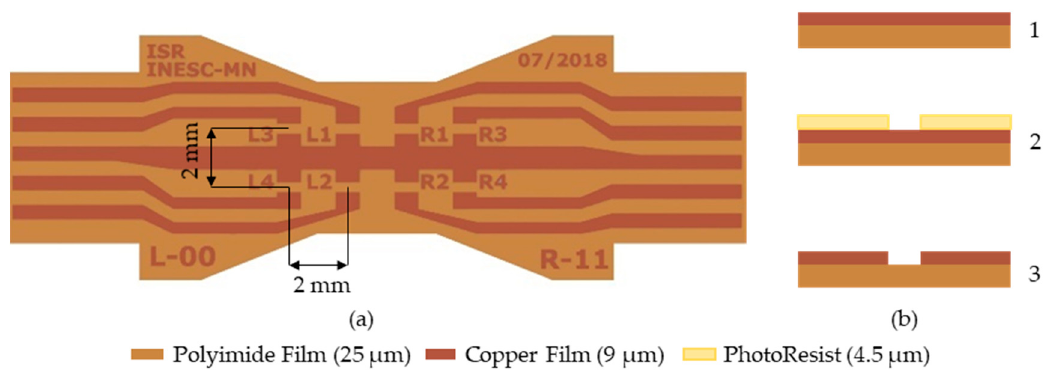
Figure 4. ( a ) Top view of the FPC, after defining the copper layer; ( b ) microfabrication steps: 1. Bare copper/polyimide film cleaning, 2. Coating and definition of photoresist using lithography system, 3. Wet etch and resist stripping.